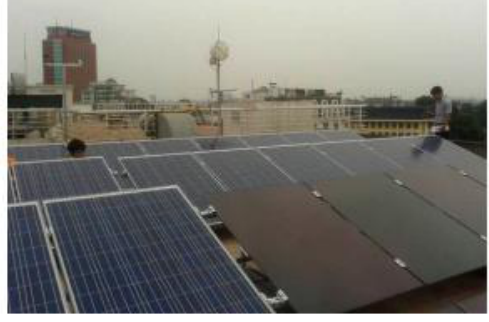
Figure 13. GDE building solar PV system [25]